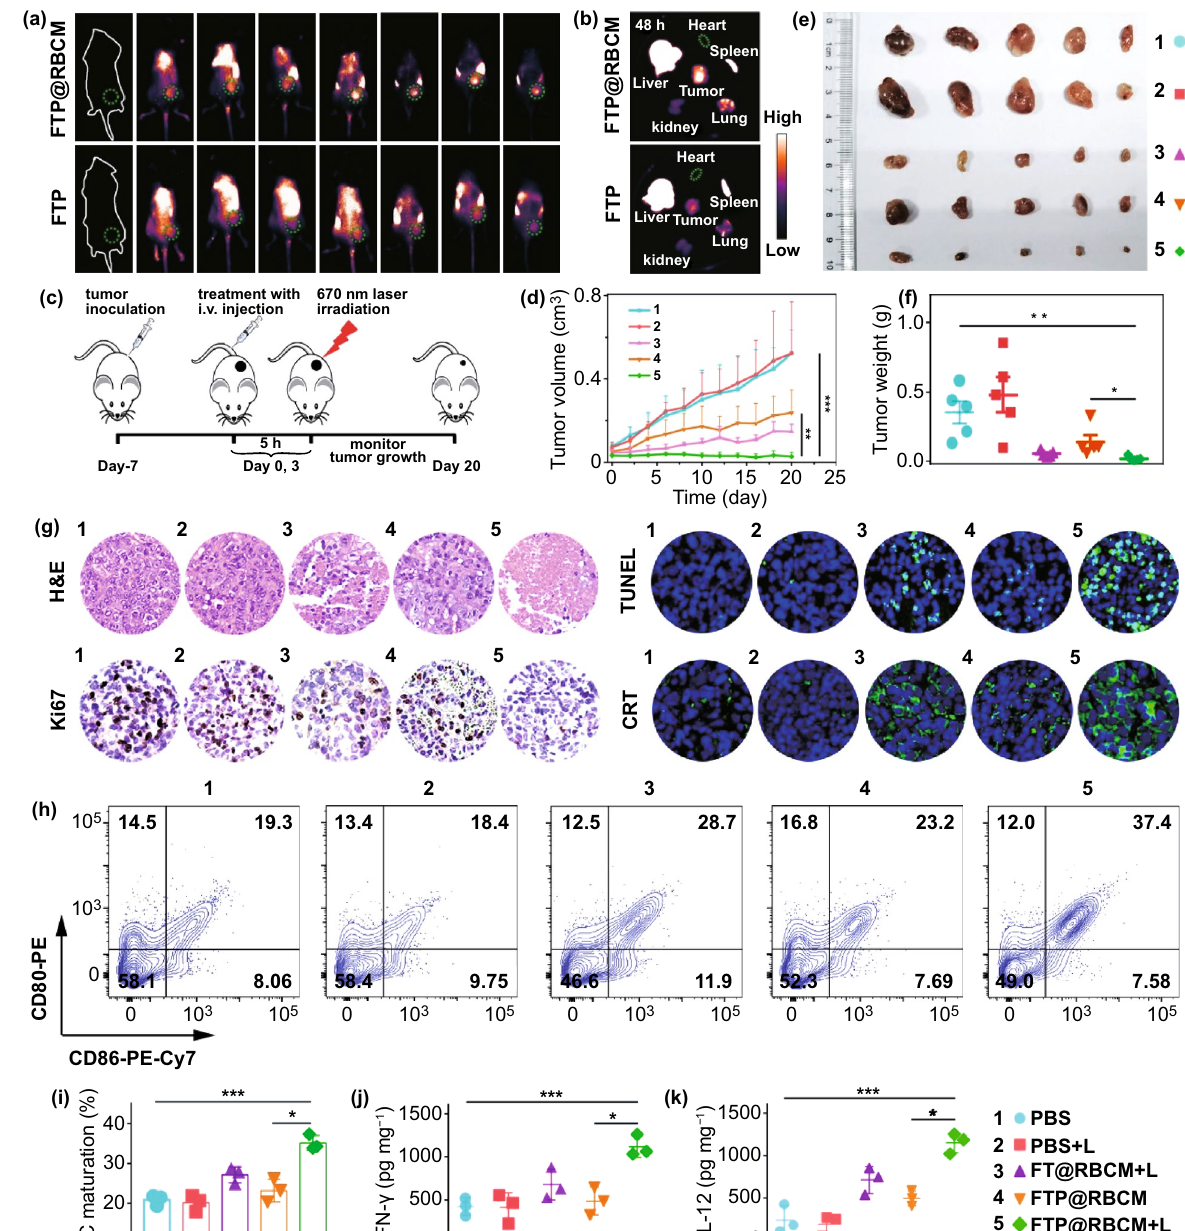
Fig. 5 a Fluorescence images of mice injected with ICG labeled FTP or FTP@RBCM. b Fluorescence images of major organs and tumors. c Schematic illustration of the therapeutic procedure of FTP@RBCM. d‑f Tumor growth curves ( d ), Ex vivo tumor photos ( e ) and average tumor weights ( f ) of mice ( n = 5). g Optical microscope images of H&E and Ki67, staining, and TUNEL and CRT immunofluorescence staining. h DC maturation in draining inguinal lymph nodes. i Percentages of maturated DCs (CD11c + CD86 + CD80 + ) ( n = 3). j, k Cytokine levels of IFN-γ ( j ) and IL-12 ( k ) in tumor tissues ( n = 3). 1: PBS group; 2: PBS + L group; 3: FT@RBCM + L group; 4: FTP@RBCM group; 5: FTP@RBCM + L